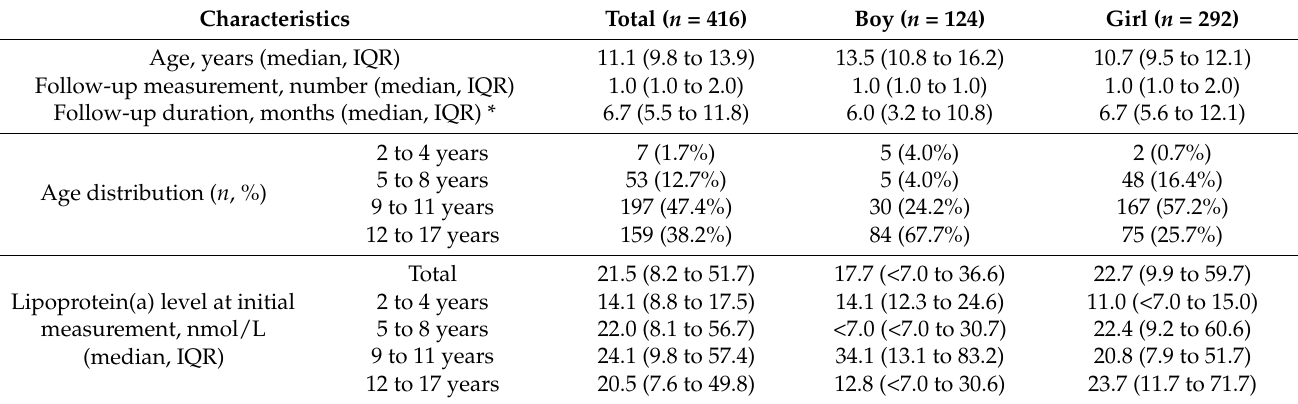
Table 1. Baseline characteristics of 416 Korean children and adolescents.